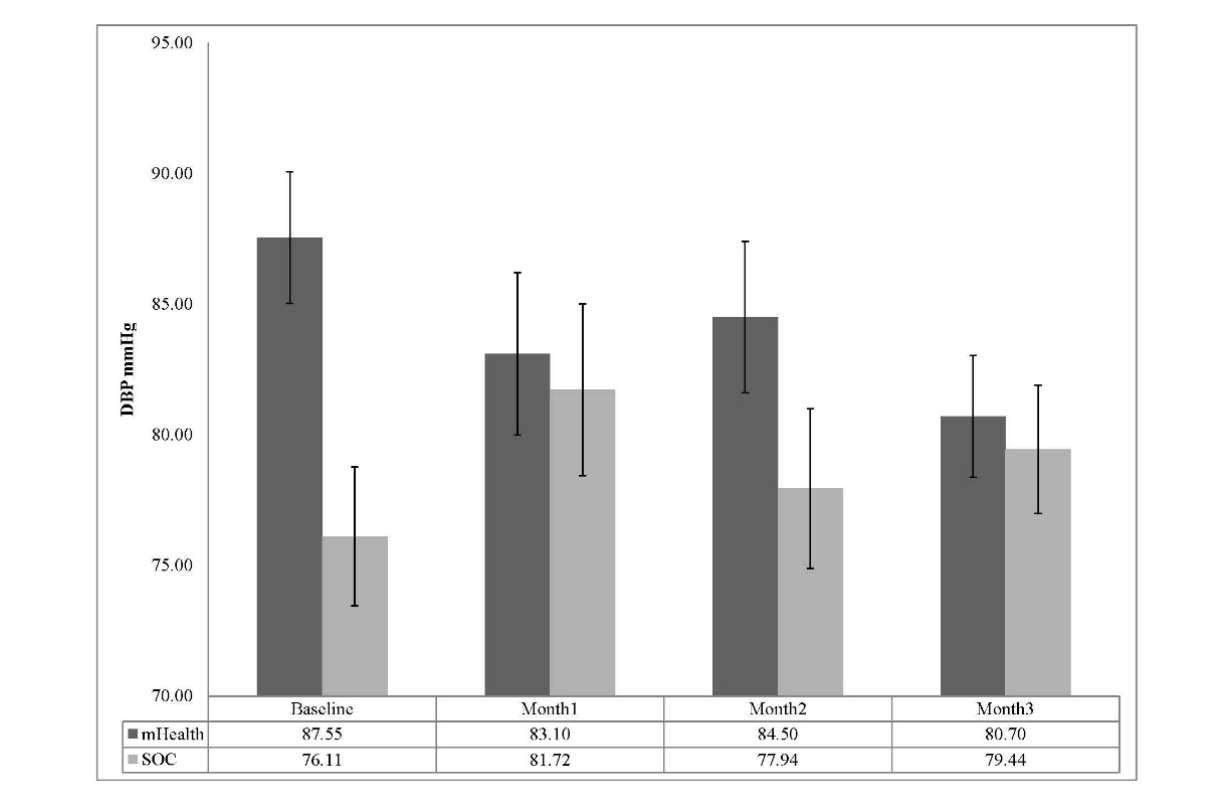
Figure 4. DBP across time by treatment group (mean with Bonferroni 95%